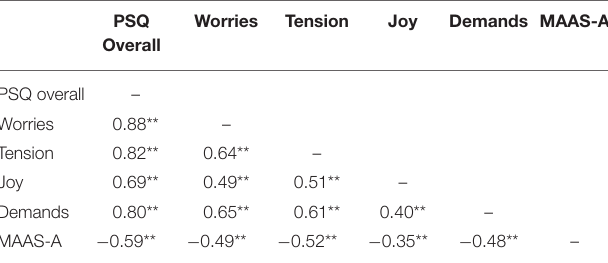
TABLE 3 | Associations (r) between the PSQ, the subscales, and the